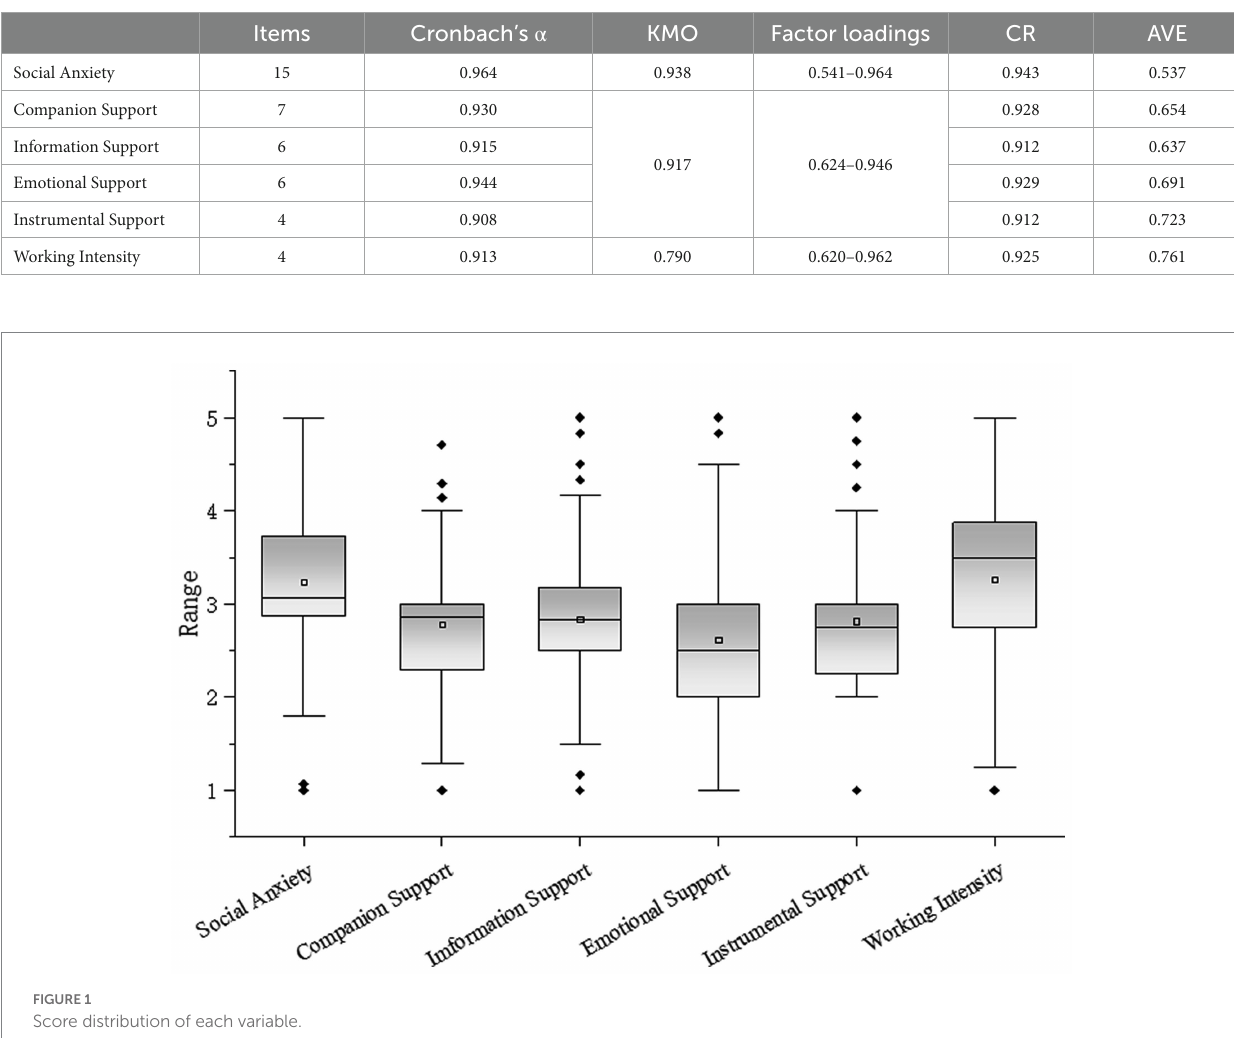
TABLE 2 Reliability and validity tests results.